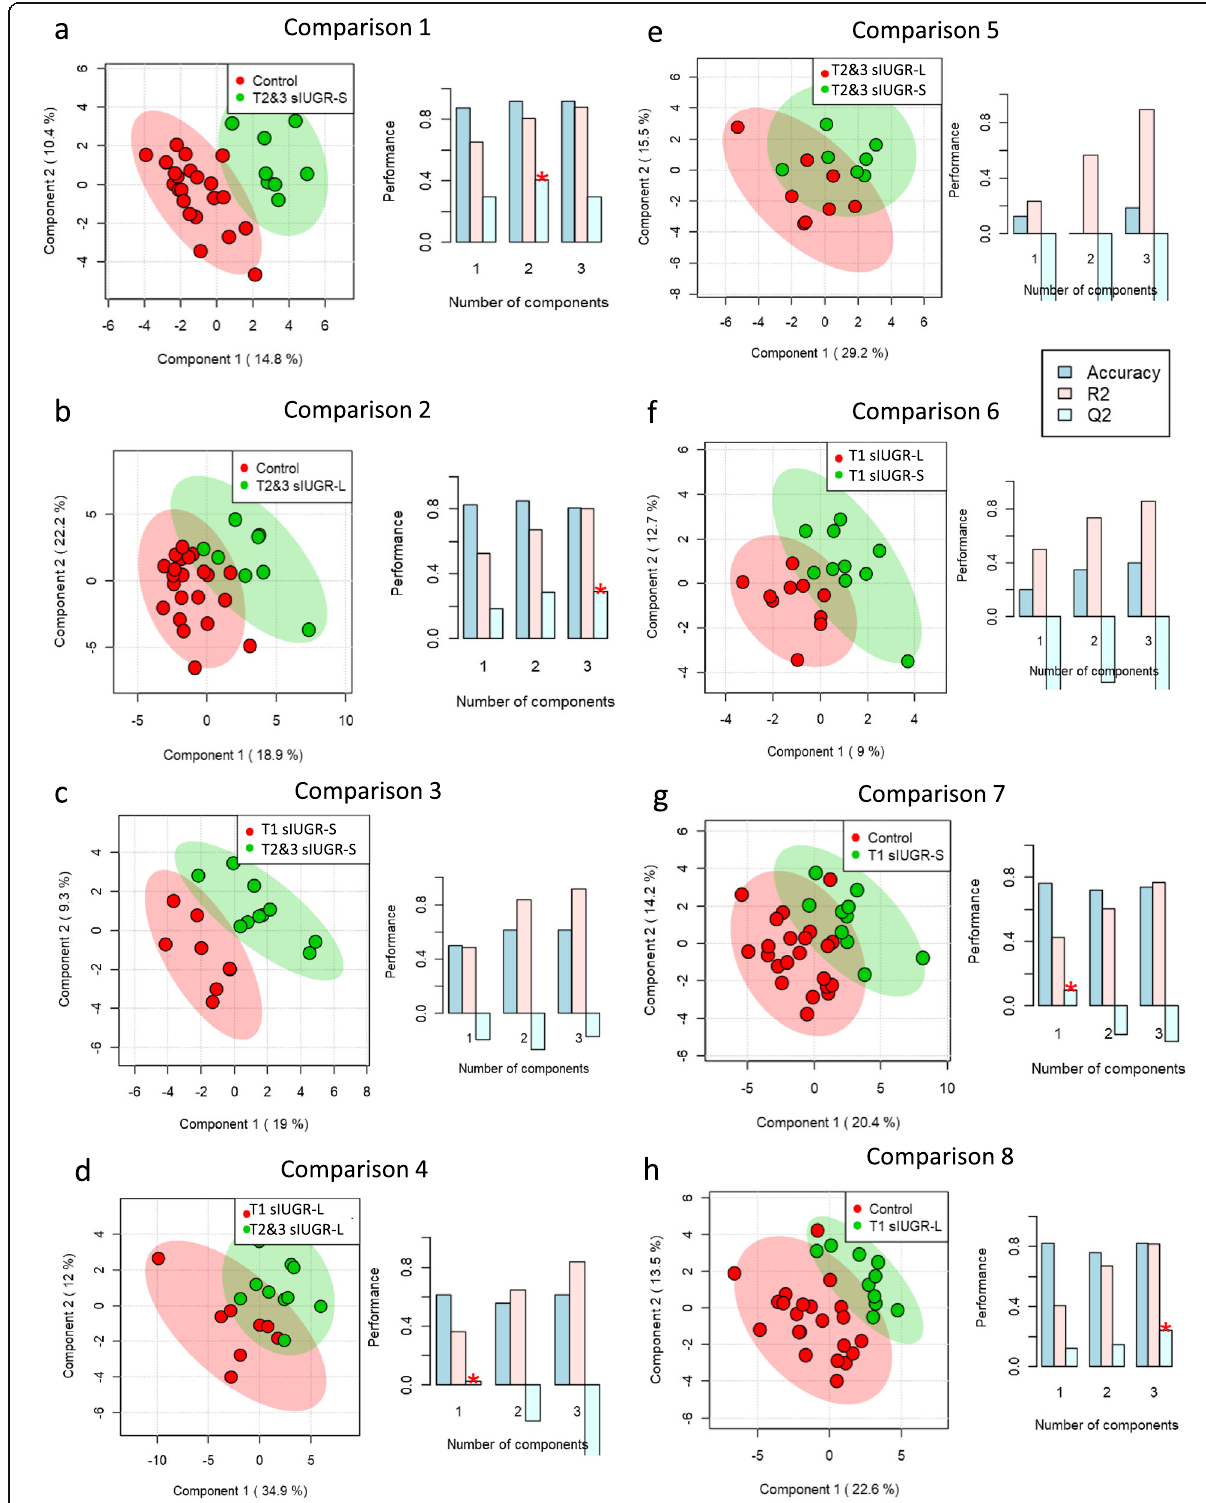
Fig. 4 (See legend on next